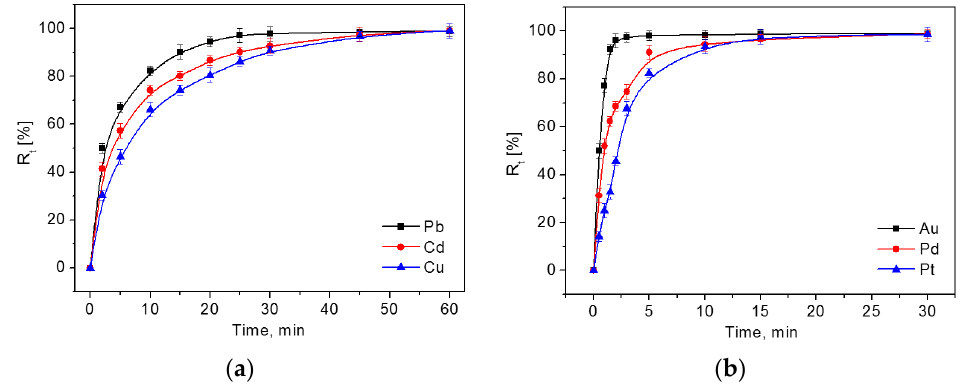
Figure 5. Effect of contact time on the adsorption of 10.0 μ g mL − 1 Cu 2+ , Pb 2+ , and Cd 2+ onto DTC-g-PE- Figure 5. E ff ect of contact time on the adsorption of 10.0 µ g mL − 1 Cu 2 + , Pb 2 + , and Cd 2 + onto DA@GB@PU ( a ) and 1.0 μ g mL − 1 Pd 2+ , Pt 4+ , and Au 3+ onto PE-DA@GB@PU ( b ). Other conditions: DTC-g-PE-DA@GB@PU ( a ) and 1.0 µ g mL − 1 Pd 2 + , Pt 4 + , and Au 3 + onto PE-DA@GB@PU ( b ). Other conditions: solution pH = 6 for DTC-g-PE-DA@GB@PU, solution pH = 0 for